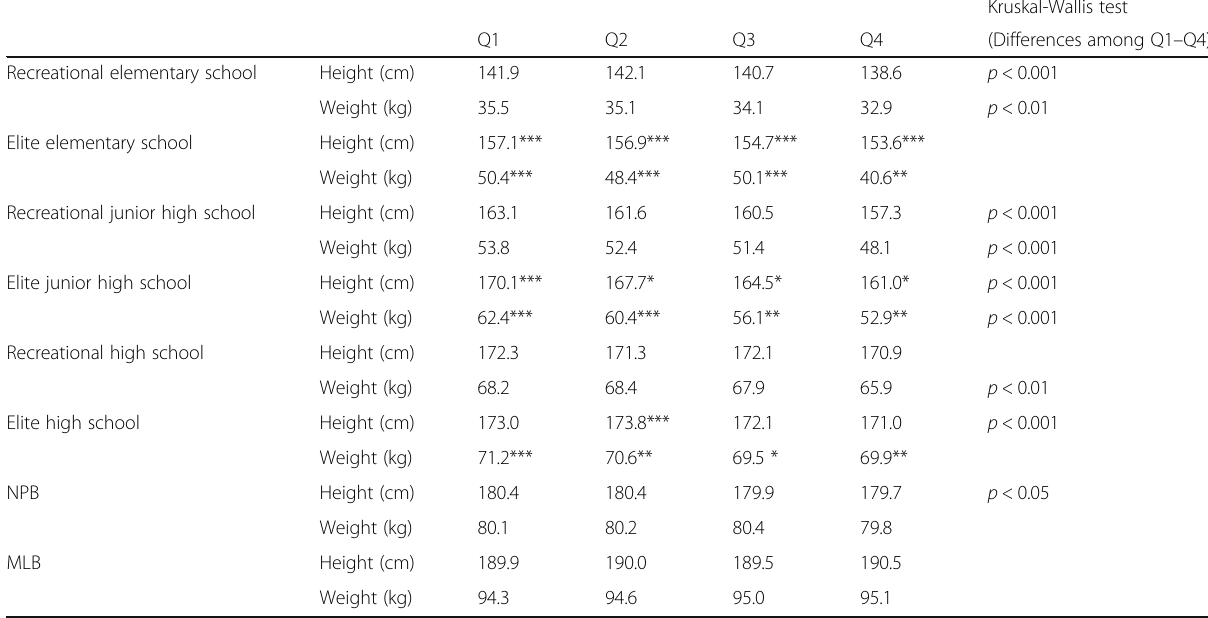
Table 5 Anthropometric data in each category